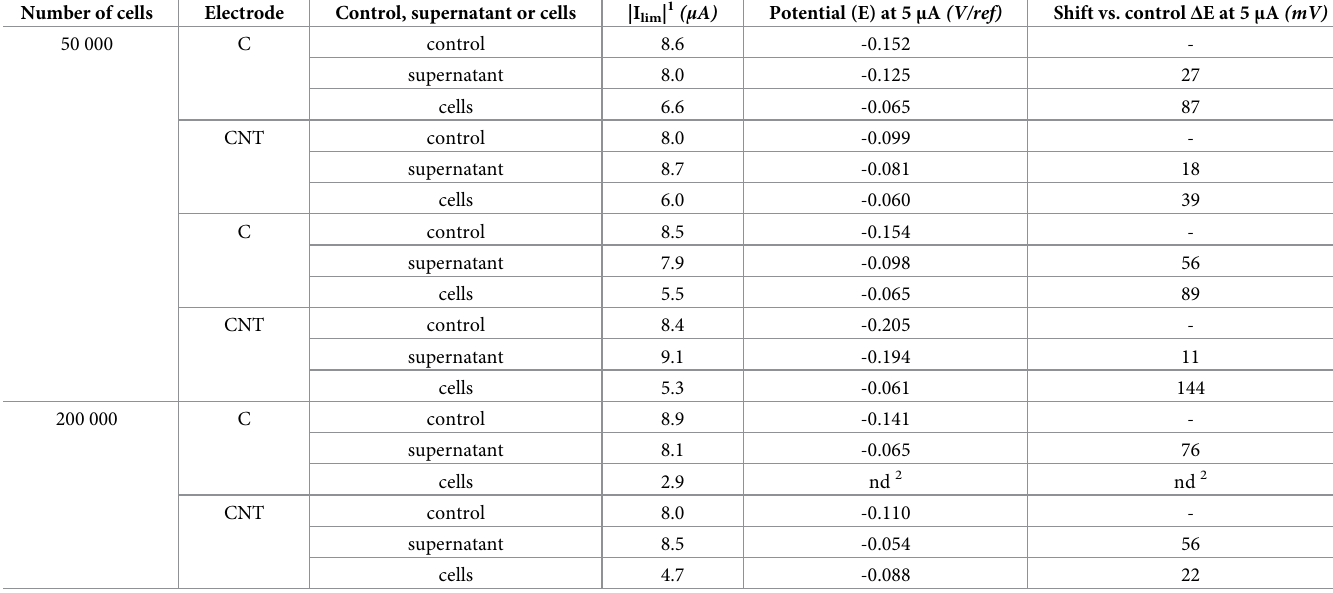
Table 3. Analysis of the reactors incubated for 24 hours with MRC5